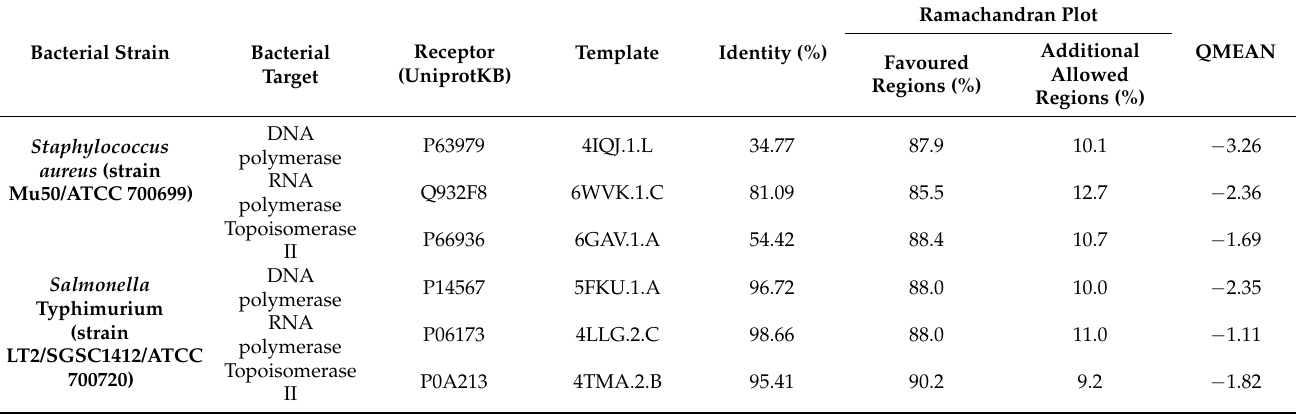
Table A1. Receptors models of the two pathogenic bacteria used to analyze the molecular docking with the major constituents of the